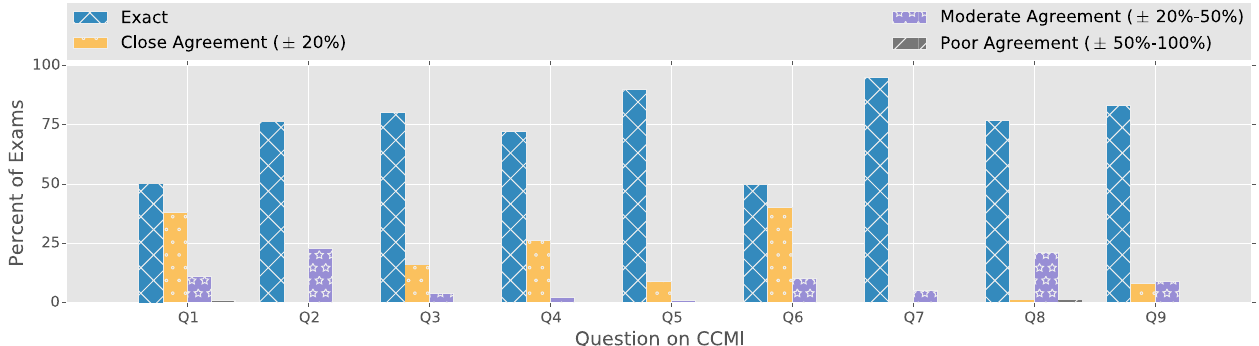
FIG. 4. For each question, the score differences between a trained and untrained grader are shown. These percentage agreement between graders was binned as exact (same score, blue), close (within (cid:3) 20% , orange), moderate (within (cid:3) 20% – 50% , purple), and poor (more than (cid:3) 50% , gray) agreement. For all questions, exact agreement was the most prevalent form of agreement ( ≥ 50% of exams for all